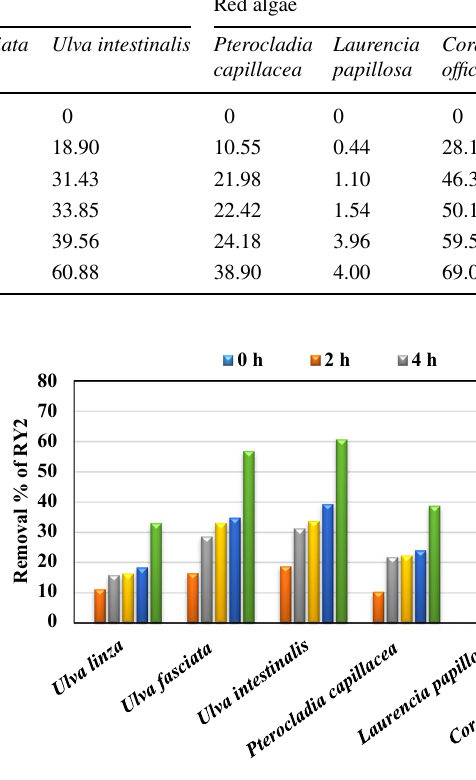
Table 3 Removal percentage of Reactive Yellow 2 (RY2) by the nine studied fresh algal species Removal % of RY2 (λmax = 404 nm) Algae